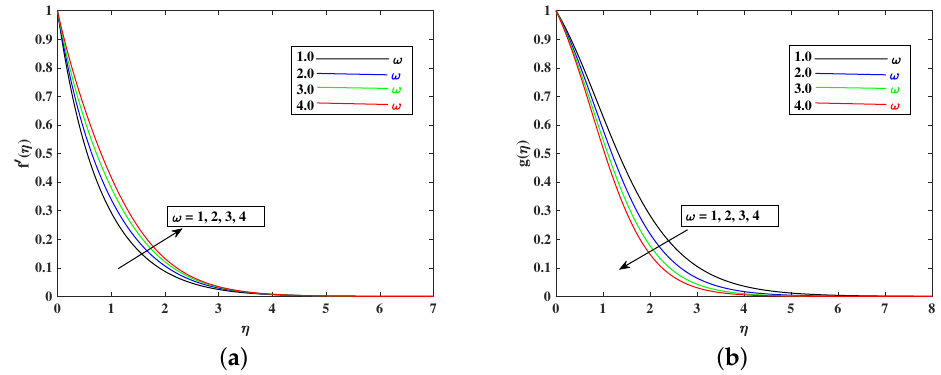
Figure 4. Variation of ω to influence the velocity and temperature profile. ( a ) Variation of ω to influence the velocity. ( b ) Variation of ω to influence the temperature.